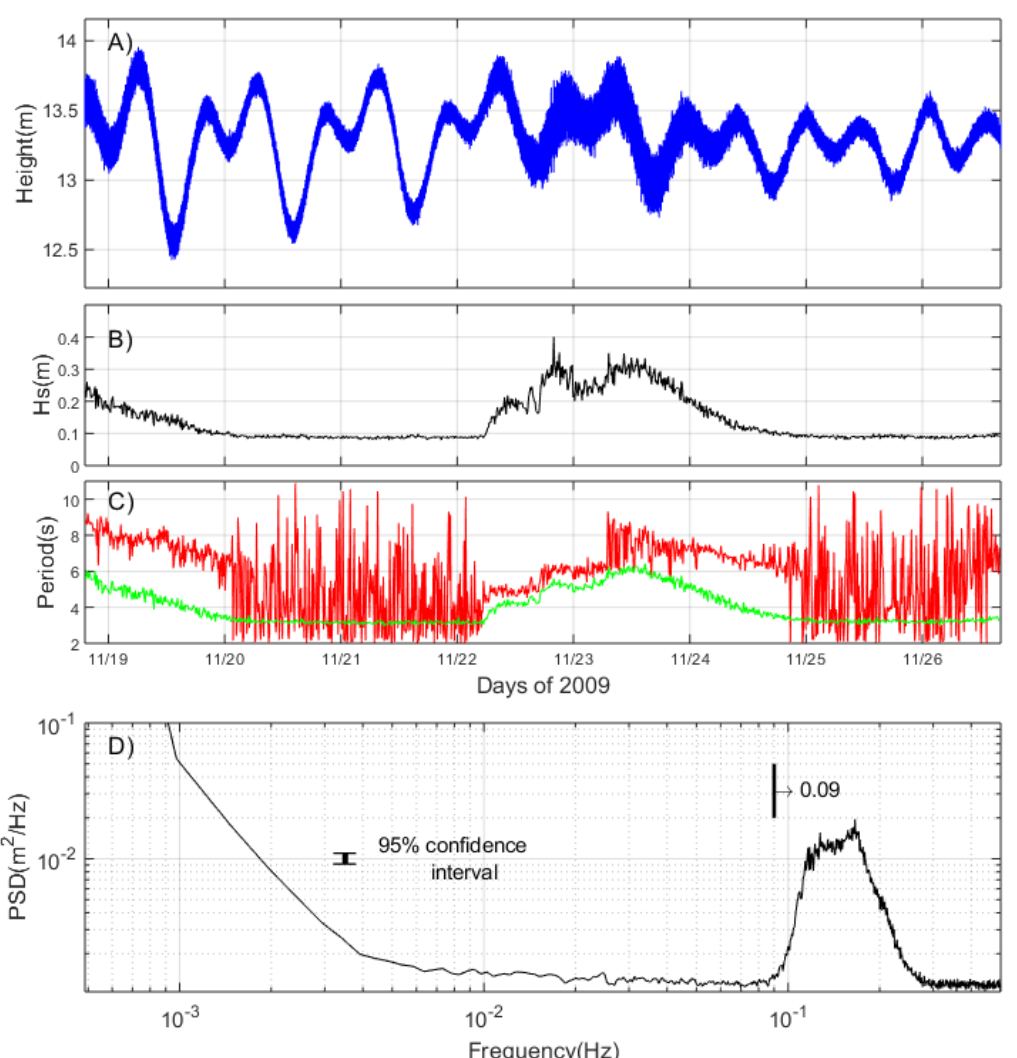
Figure 1. Data from the northeastern Gulf of Mexico, in the Florida Big Bend region. ( A ) Time series of water surface height (m), ( B ) Significant wave heights (Hs), ( C ) Dominant wave period (DPD) in red and Average wave period (APD) in green, and ( D ) Power Spectral Density (m 2 / Hz) of the time series shown in (A).